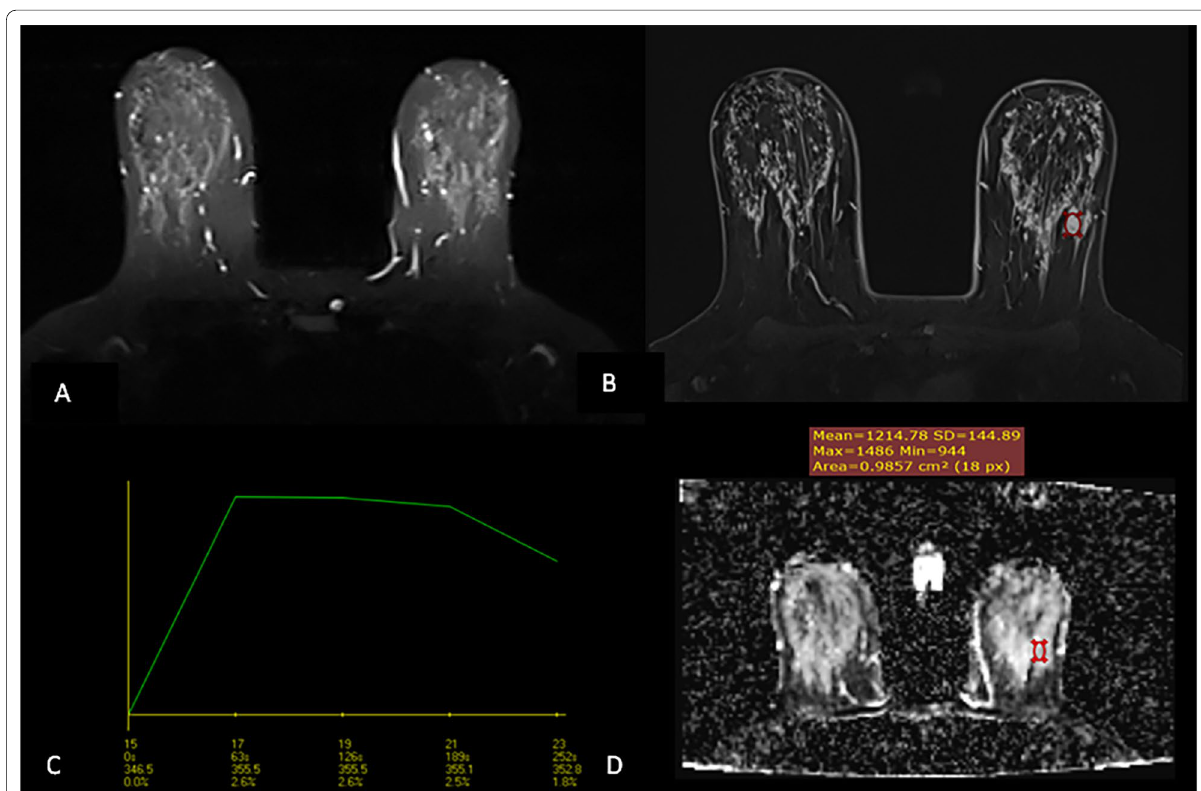
Fig. 6 Case 5: 44 Years old presenting with a palpable left breast mass. Sonomammographic assessment revealed UOQ focal parenchymal distortion (not illustrated on images). DCE‑MRI: STIR ( A ), post‑contrast dynamic sequences ( B ) with time–intensity curves ( C ), and ADC mapping ( D ) revealed UOQ mass enhancement showing type III washout curve on plotting time–intensity curve ( C ) and ADC value of 1.21 (D) U/S guided trucut histopathology revealed sclerosing adenosis and ADH and apocrine metaplasia. Wire localization and excision was recommended by MDT,